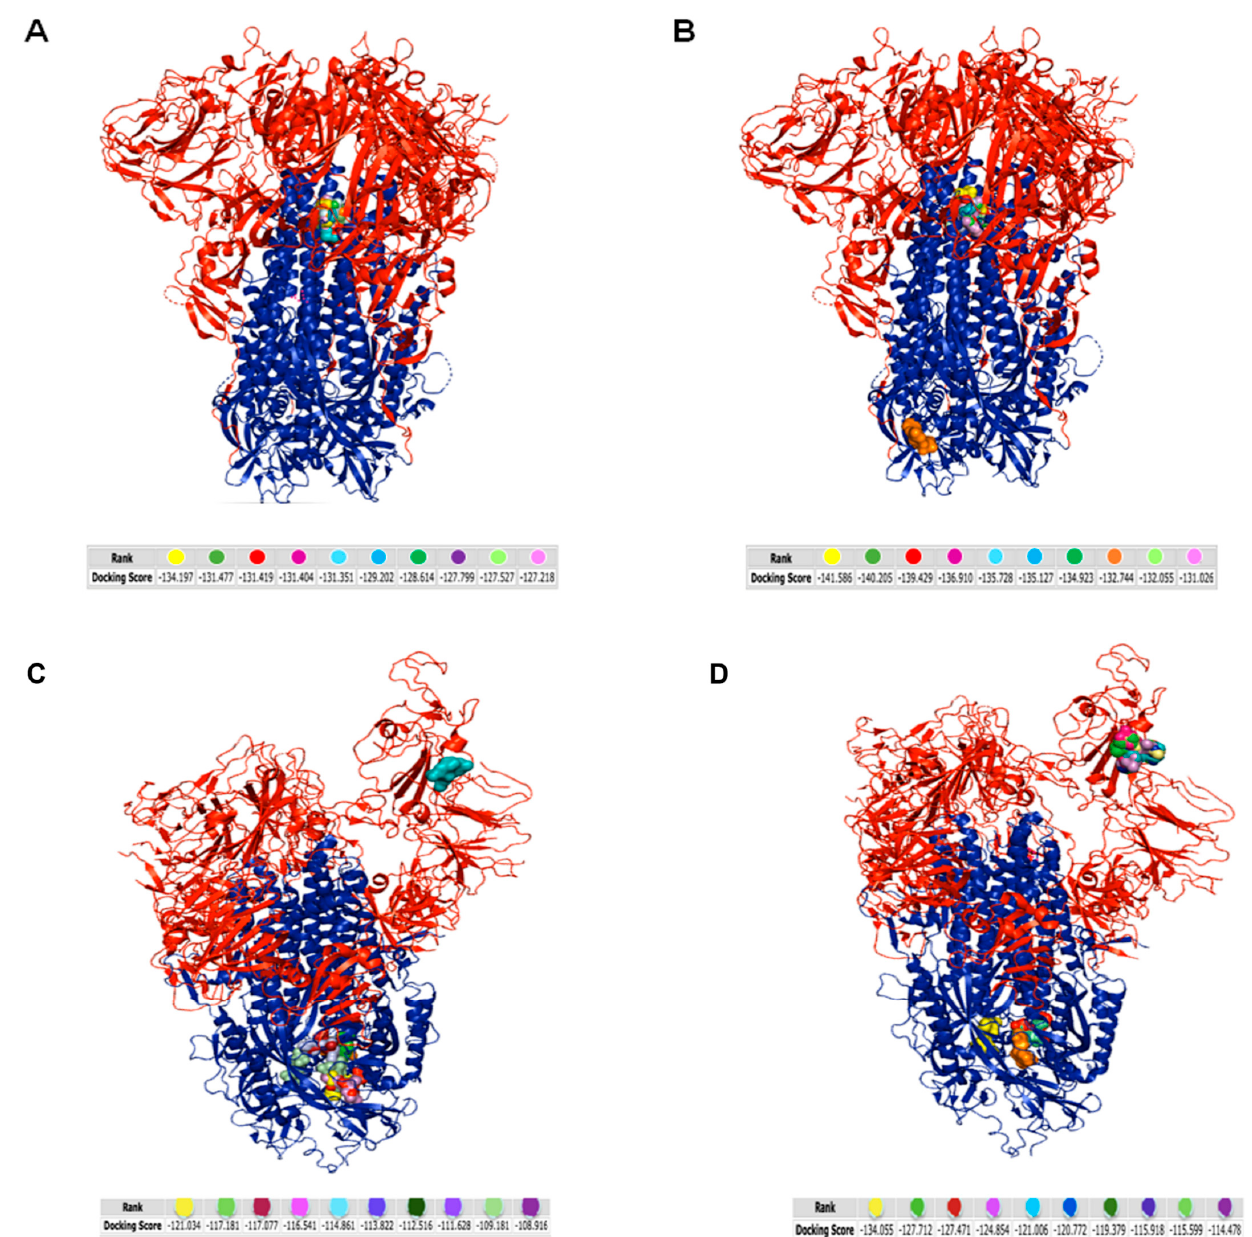
Figure 4. Molecular simulation of tripeptides interacting with HCoV-OC43 and SARS-CoV-2 spike protein obtained by HPEPDOCK server: ( A ) TLH/HCoV-OC43 spike protein; ( B ) VFI/HCoV-OC43 spike protein; ( C ) TLH/SARS-CoV-2 spike protein; ( D ) VFI/SARS-CoV-2 spike protein. The red color indicates the S1 subunit and the blue color the S2 subunit of the spike protein. The different color code of peptides, represented as balls, refers to the different binding free energy.